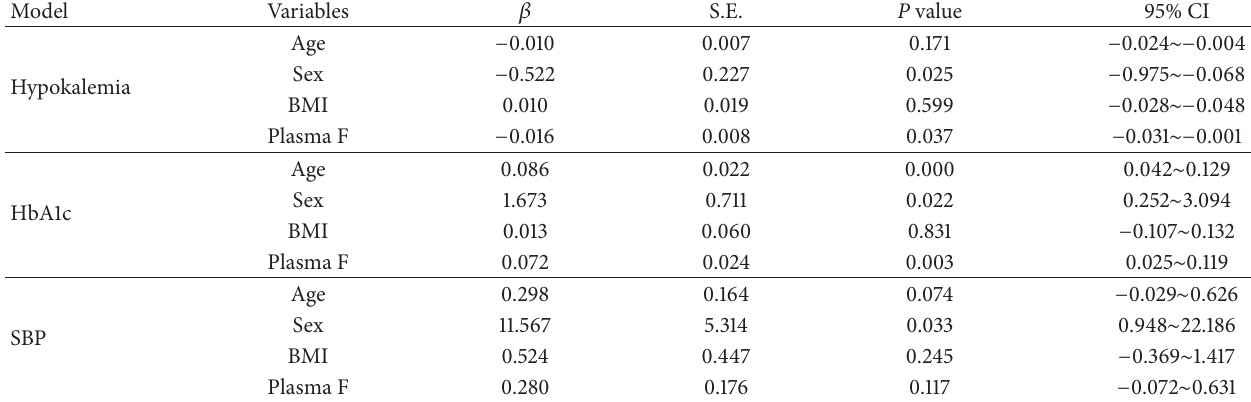
Table 2: Linear regression analysis for hypokalemia, HbA1c, and systolic blood pressure.